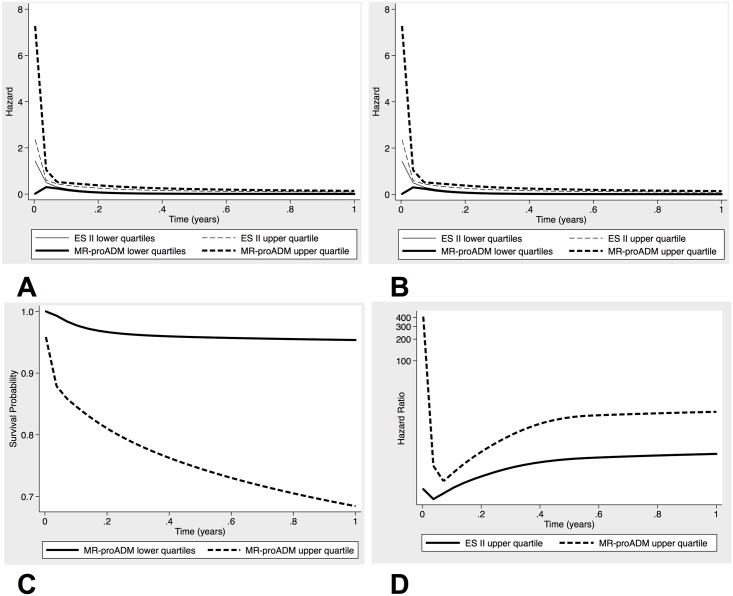
Mortality rates of patients receiving TAVR, grouped by upper quartile of MR-proADM and EuroSCORE II.(A) Hazard rates. (B) Cumulative hazard rates. (C) Cumulative survival probabilities. (D) Hazard ratio (ES II = EuroSCORE II).